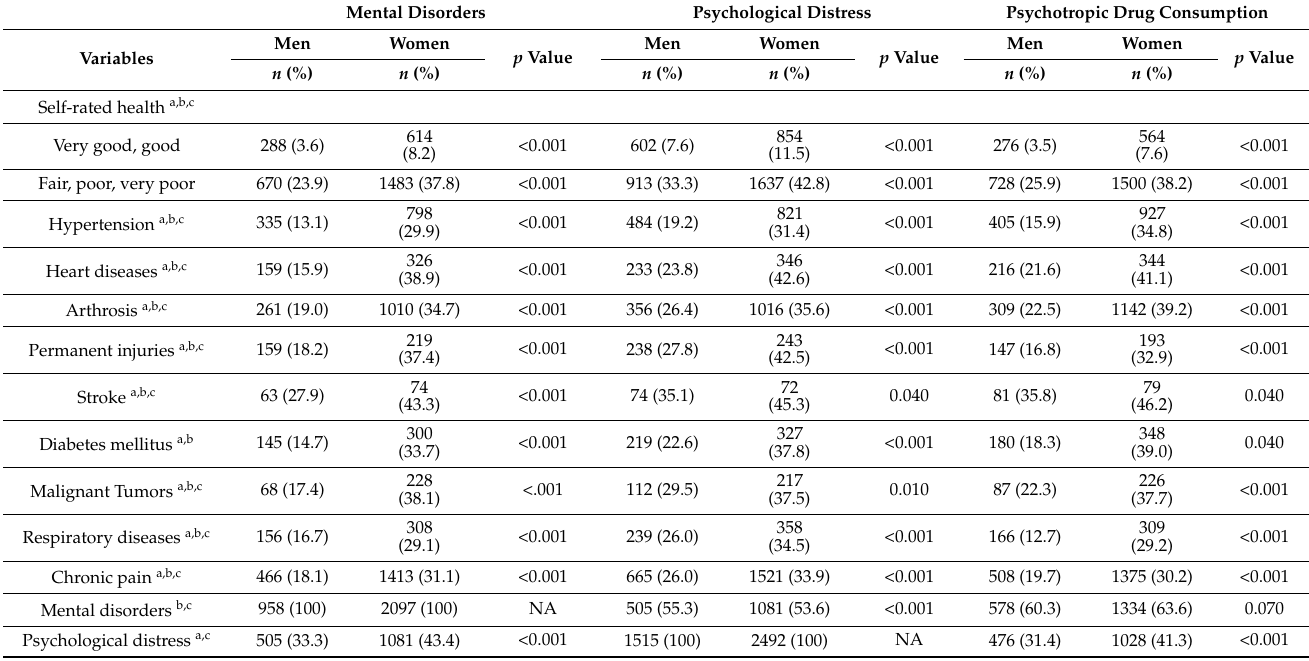
Table 2. Mental disorders, psychologic distress and psychiatric drug consumption according to health status variables. Results from the Spanish National Health Interview Survey 2017.